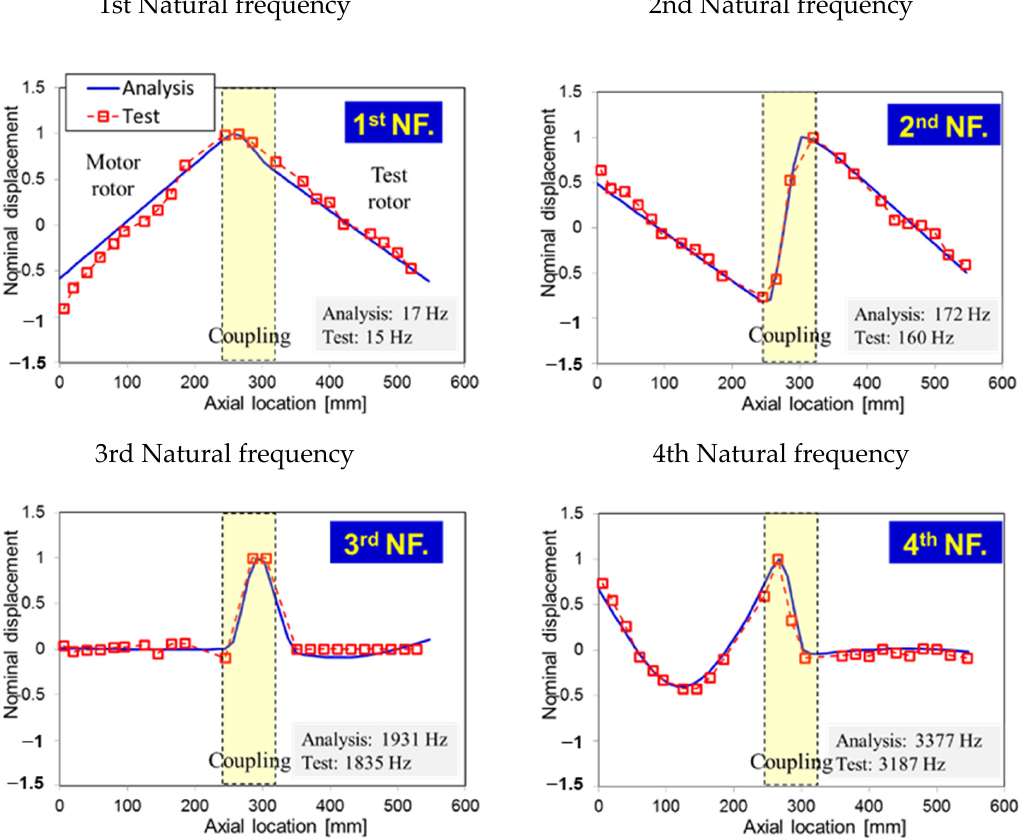
Figure 8. Measured and predicted mode shapes of a dual rotor for first through fourth order.